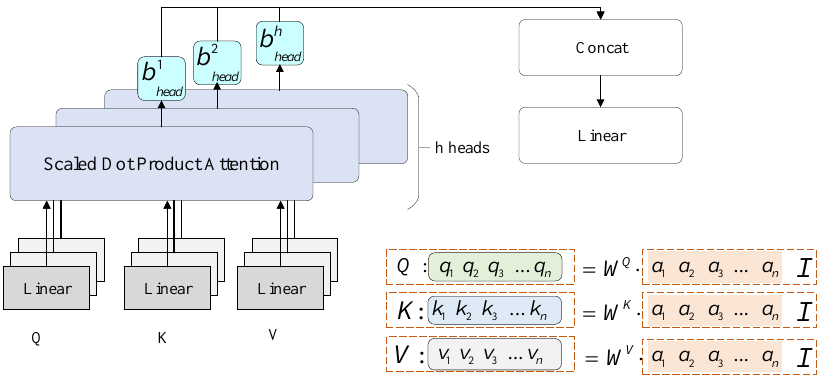
Figure 3. Multi-head self-attention module. The inputs I = [ a 1 , a 2 , a 3 , . . . , a n ] are multiplied by the learnable matrices W Q , W K , and W V to obtain the novel matrices Q , K , and V . Then, Q , K , and V are fed into a scaled dot-product attention to obtain the attention matrix b i . The multi-head self-attention module performs this scaled dot-product attention h times parallelly, and concatenates each output b i with linear